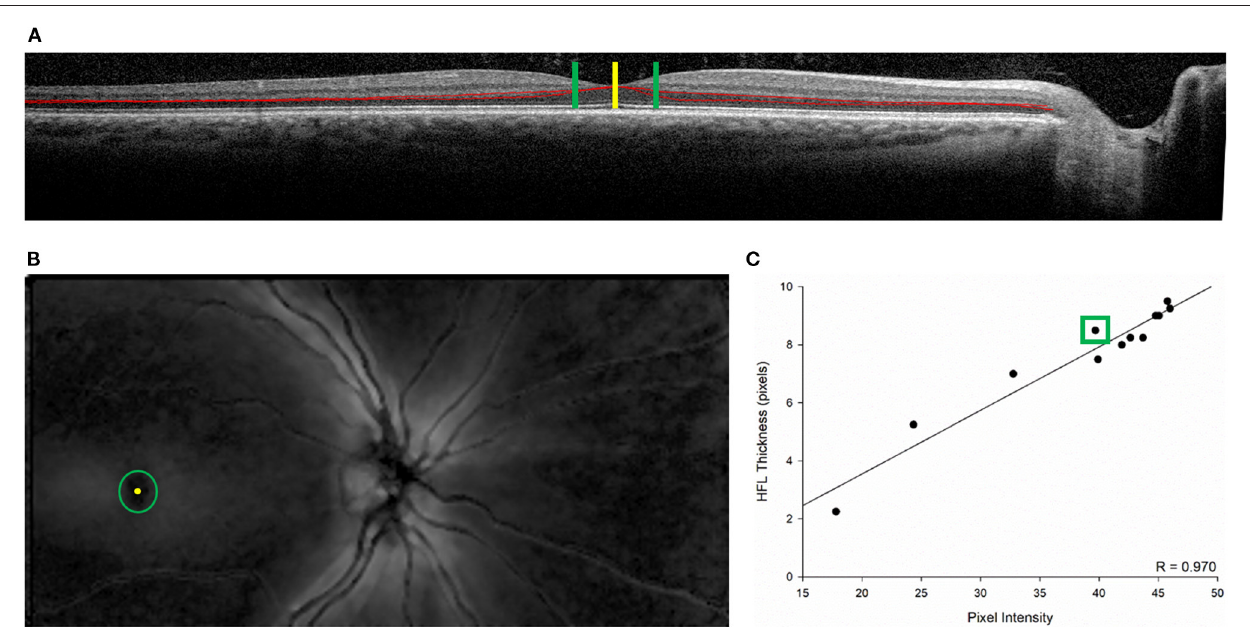
FIGURE 5 | Example of the association between Henle fiber layer (HFL) thickness and phase retardation in an individual subject from the second cohort. (A) Directional optical coherence tomography image along the horizontal axis with the HFL outlined in red. The yellow vertical bar represents the center of the fovea. The green vertical bars mark 1 ◦ of eccentricity (temporal on the left and nasal on the right) from the center of the fovea. (B) Scanning laser polarimetry image of the posterior pole. Bright regions within the image indicate high phase retardation caused by tissue birefringence. The yellow circle marks the center of the fovea. The green ring indicates 1 ◦ of eccentricity from the center of the fovea. (C) Regression plot showing the association between pixel intensity (a proxy for magnitude of phase retardation) and HFL thickness. The data point in the green box represents (i, y-axis) HFL thickness averaged from the superior, inferior, nasal (right green bar in A ), and temporal (left green bar in A ) meridians 1 ◦ from the central fovea and (ii, x-axis) phase pixel intensity averaged along an eccentric ring (green ring in B ) 1 ◦ from the central fovea. The other data points represent the other eccentricities measured (0 ◦ -3 ◦ eccentricity in 0.25 ◦ steps from the center of the